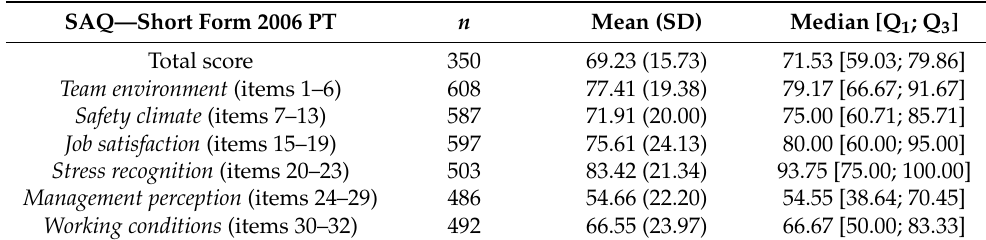
Table 2. Descriptive analysis of the SAQ—Short Form 2006 PT: mean (SD); median [Q1; Q3] of total score and per domain.